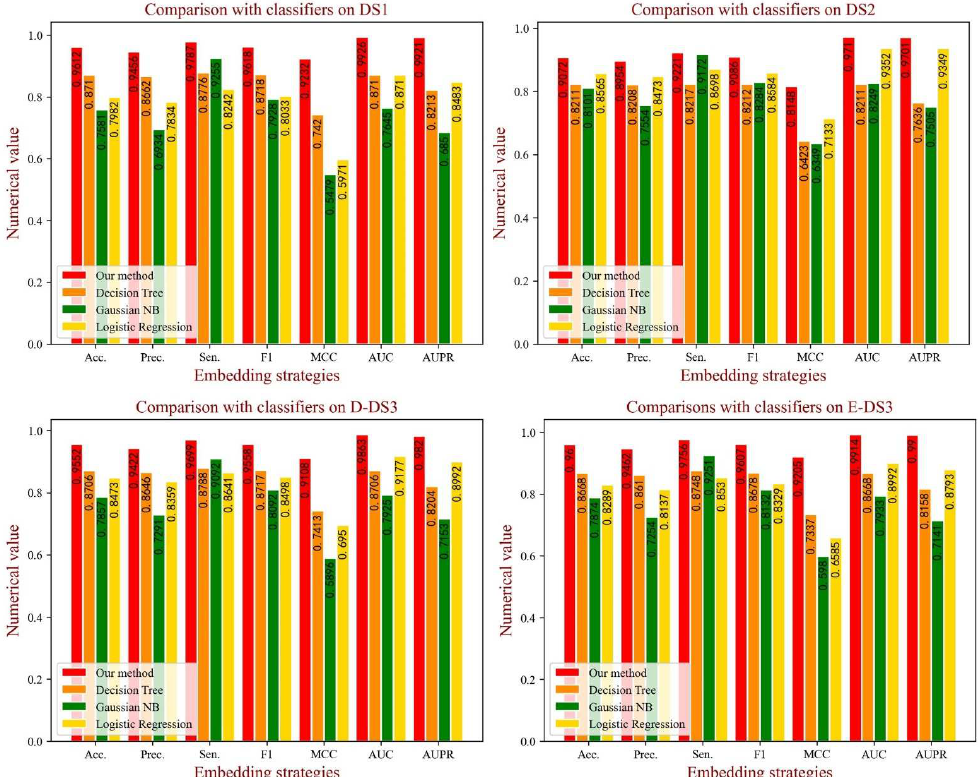
Figure 9. The performance of different classifiers on each dataset.